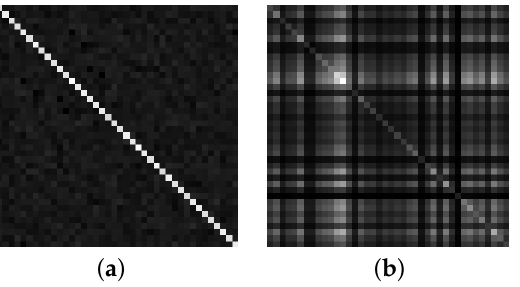
Figure 2. Grayscale images of the sample covariance matrix of the noise and signal with 40 orthogonal dual-polarization antennas: ( a ) H 0 under R x ( N ) ; ( b ) H 1 under R x ( N ) .